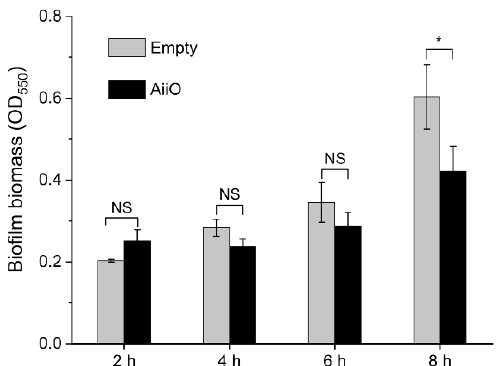
Figure 6. Effect of QQ enzyme on the biofilm formation on the PE microplastic surface. Error bars were defined as standard deviations (n = 3, biological replicates). A two-way ANOVA was performed and the Bonferroni post hoc test was conducted to compare the QQ treatment (AiiO) to the negative control (Empty), where significant differences are indicated as follows: NS, not significant p > 0.05 and * p < 0.05.